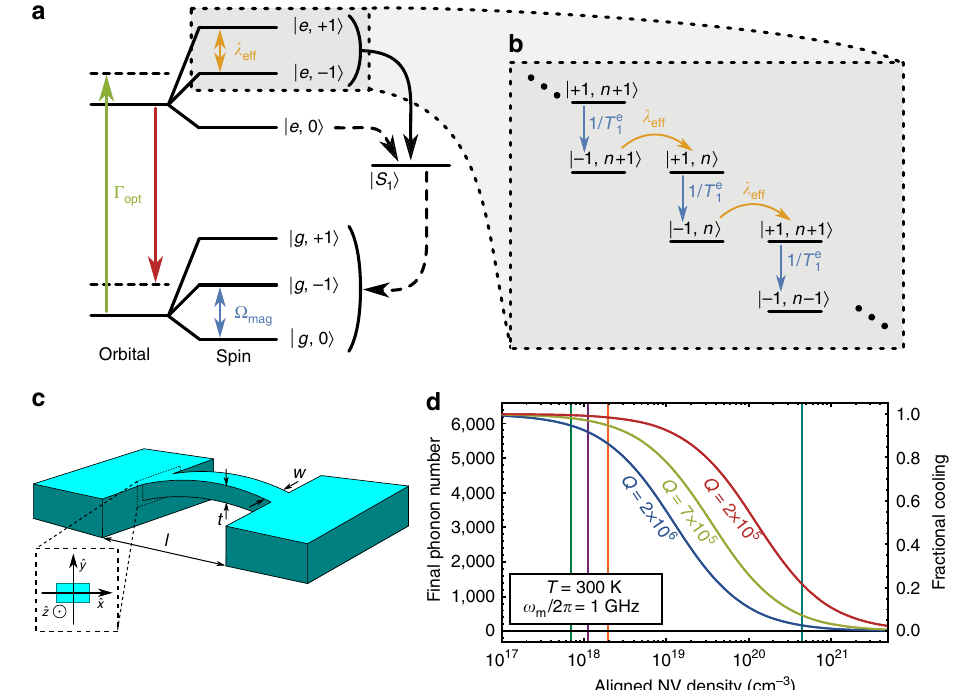
Figure 4 | A dissipative protocol for cooling a mechanical resonator. ( a ) The seven NV centre orbital and spin states at room temperature. Fast (slow) transitions are indicated by solid (dashed) one-way arrows. Coherent couplings are indicated by two-way arrows. ( b ) The toy model depiction of the proposed cooling protocol. ( c ) Schematic of a doubly-clamped beam. ( d ) Final phonon number achieved by the cooling protocol as a function of the density of properly aligned NV centers. Vertical lines indicate densities that have been realized in single-crystal diamonds (7.0 (cid:9) 10 17 cm (cid:3) 3 (ref.